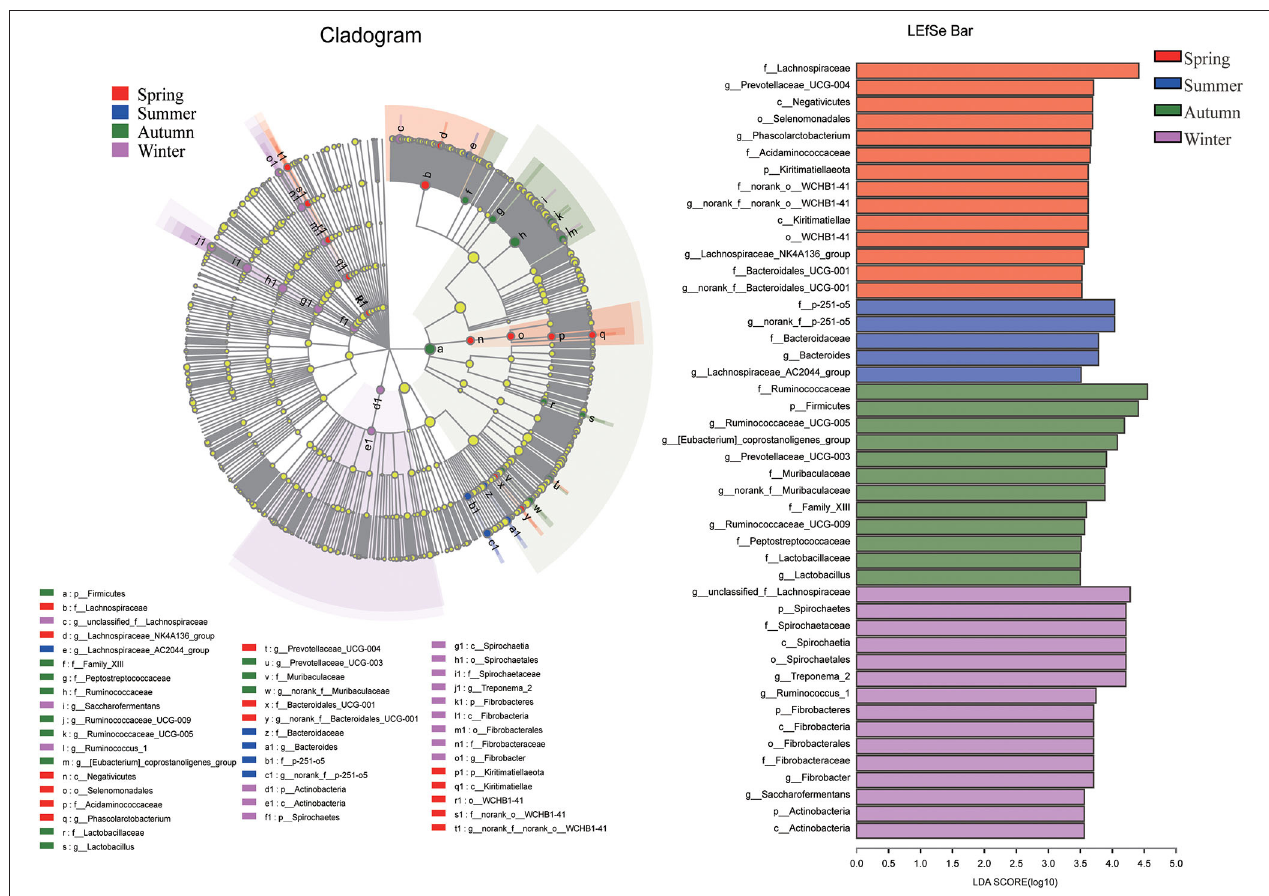
FIGURE 5 | LEfSe analysis. There were statistically significant differences in abundance between any two seasons based on LDA distribution histograms and phylogenetic distribution of